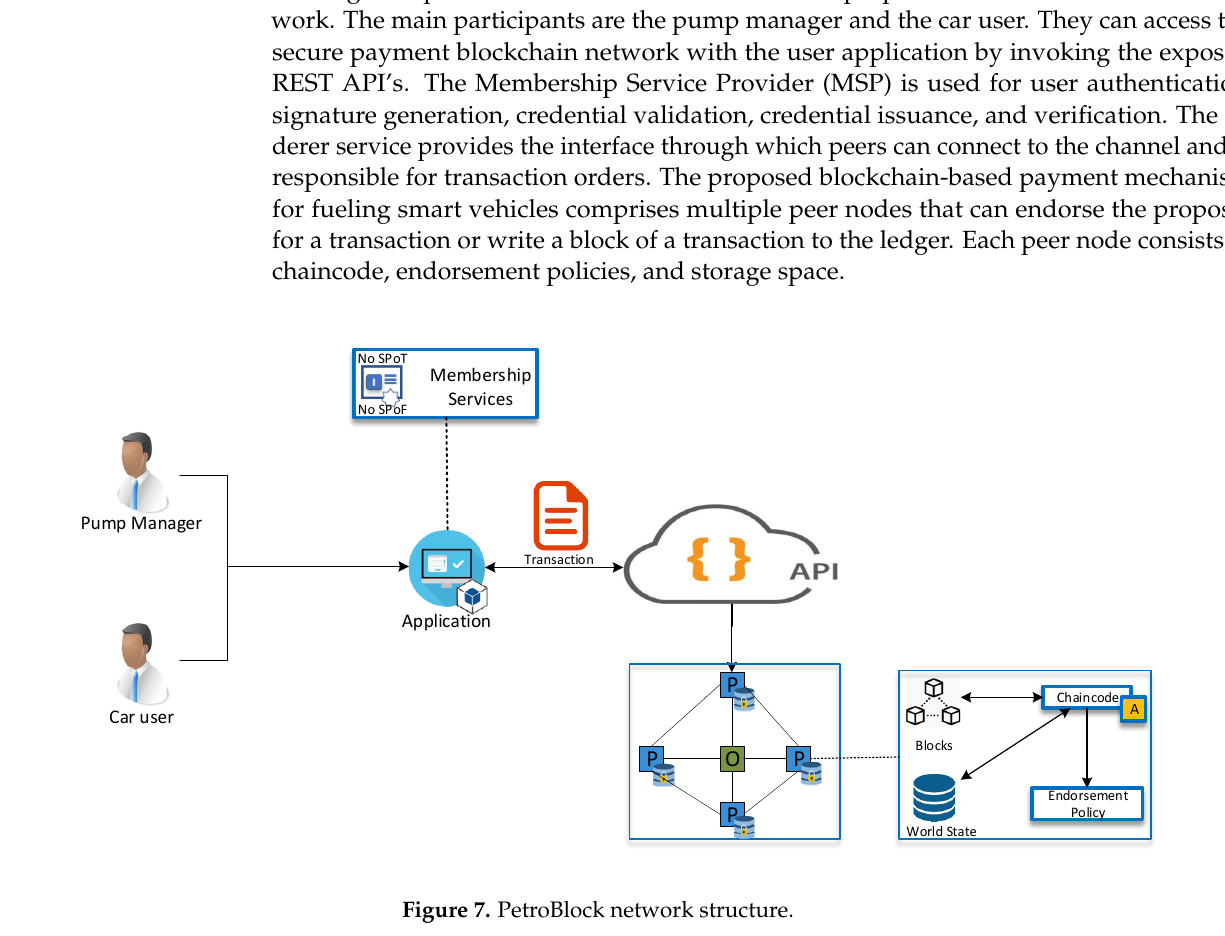
Figure 7. PetroBlock network